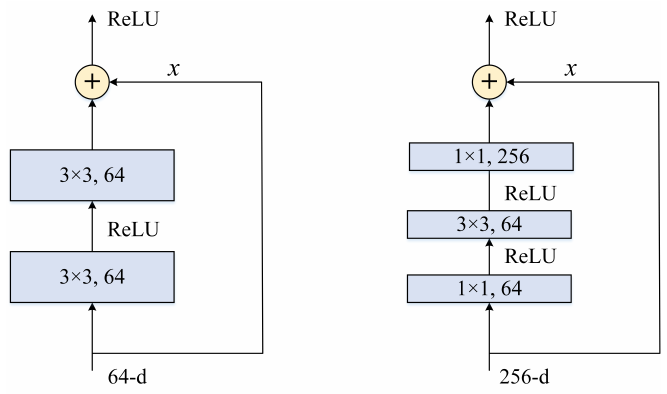
Figure 16. Two building blocks for